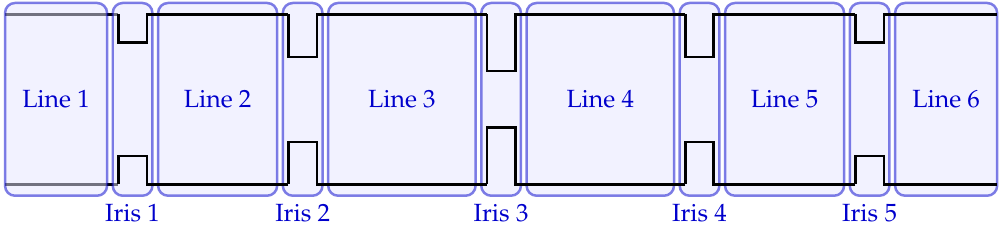
Figure 2. Segmentation of the coupled cavities all-metallic filter in rectangular waveguide into simple building blocks (empty line sections and